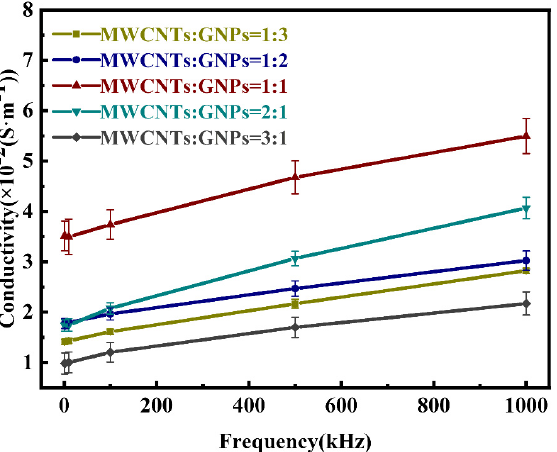
Figure 7. Conductivity of a print-shaped sample filled with two components of different ratios.